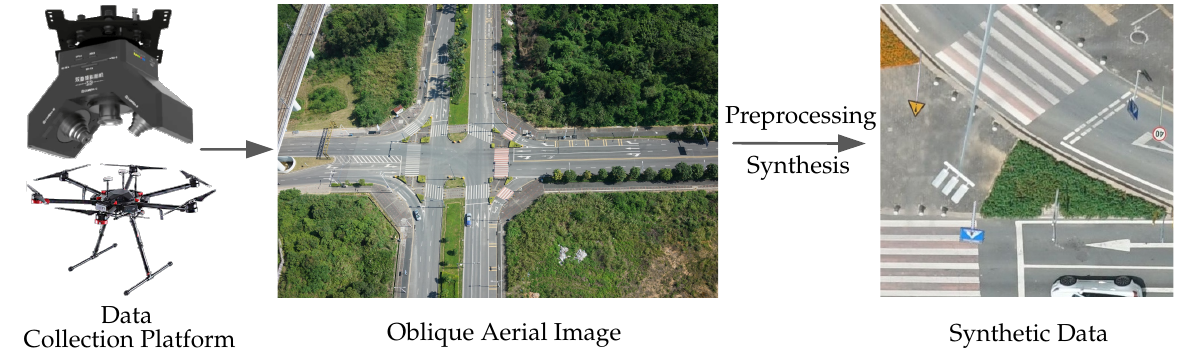
Figure 10. The process of oblique aerial image collection, preprocessing and synthesis. We split the training dataset into two groups by randomly selecting 70% of the images for training and the remaining 30% for testing and altered the obtained images 24 times via rotation, mirror transformation and gamma transformation to avoid overfitting. Original and synthetic training data are presented in Figure 12. The final set includes 450 images with a pixel size of 1024 1024. ×